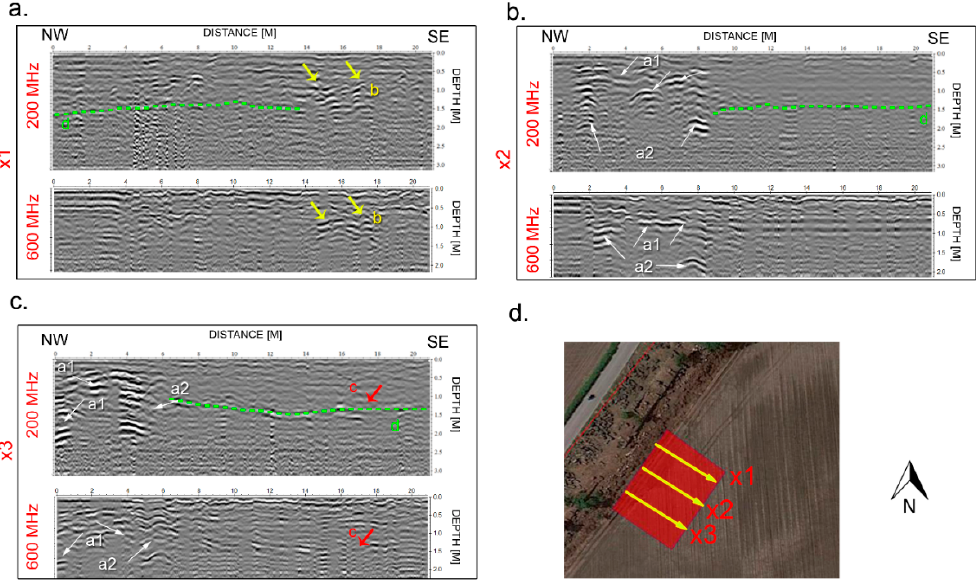
Figure 6. Radargrams collected at frequencies of 200 MHz and 600 MHz along the three profiles ×1 ( a ), ×2 ( b ), ×3 ( c ) distributed on the investigated area ( d ). The main anomalies are indicated by labels and arrows and described in the